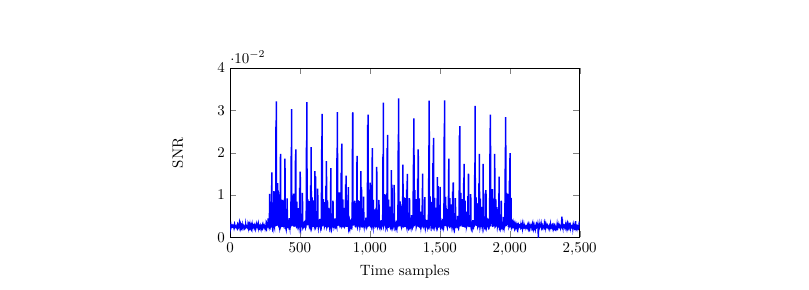
Figure 9: SNR result over the different time samples for the real shuffled AES traces, when only varying the first plaintext byte.